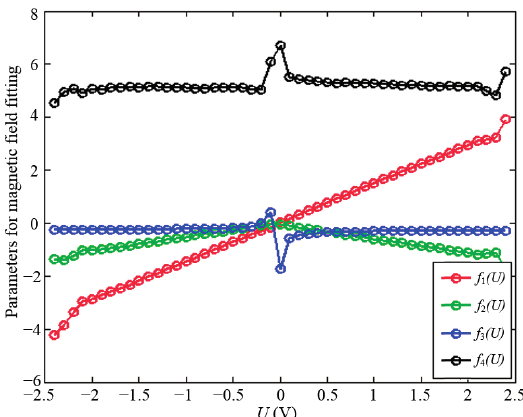
Figure 10. Parameters of the elliptic function. Each curve represents one parameter in